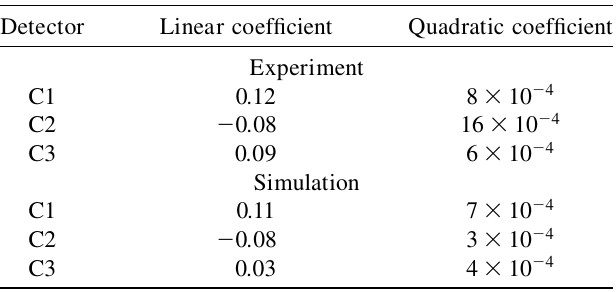
TABLE I. Measured and simulated linear and quadratic ex- pansions of the compression efficiency map at the three detec- tor locations (C1, C2, and C3).